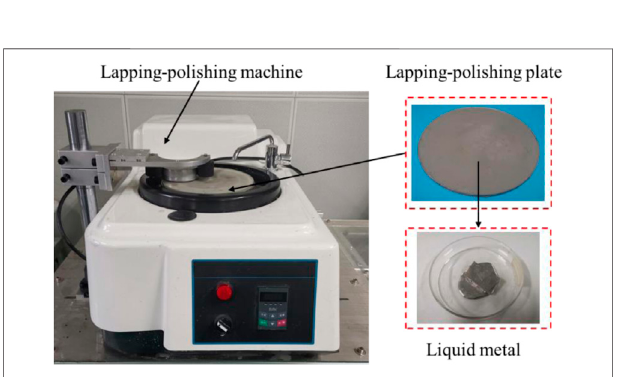
FIGURE 8 | Experimental